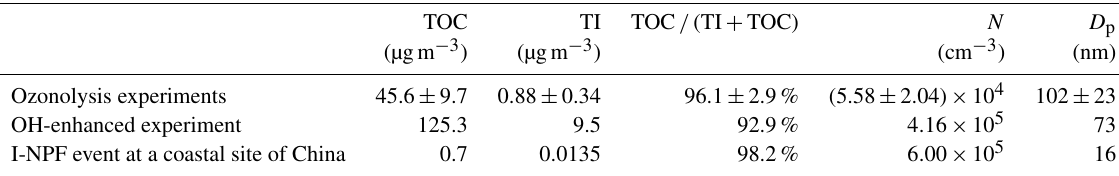
Table 2. Particle number concentration ( N ), mean diameter ( D p ), total organic carbon (TOC) and total iodine (TI) of new particles with a residential time of 67min in the bag reactor in the ozonolysis experiments and OH-enhanced experiment (dynamic mode). Those of 10– 56nm new particles collected by a nano micro-orifice uniform deposit impactor (nano-MOUDI; MSP, Inc.) during an I-NPF event at a coastal site of Ningbo, China (Yu et al., 2019), are also